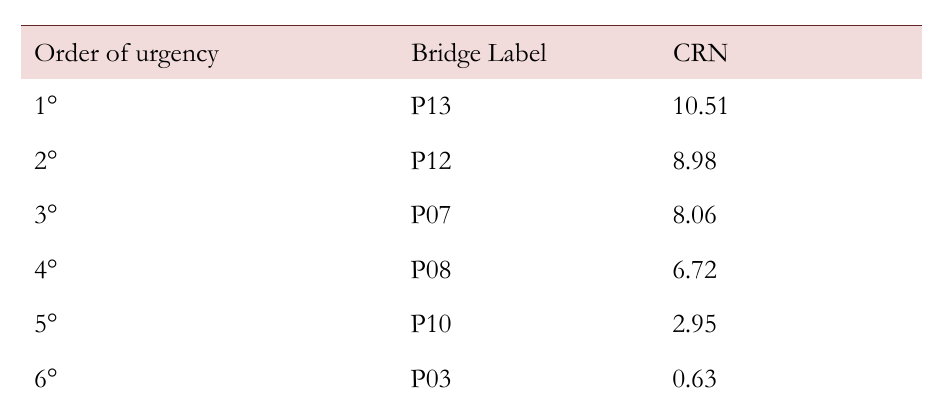
Table 9: Damage estimation for bridge P08 components.